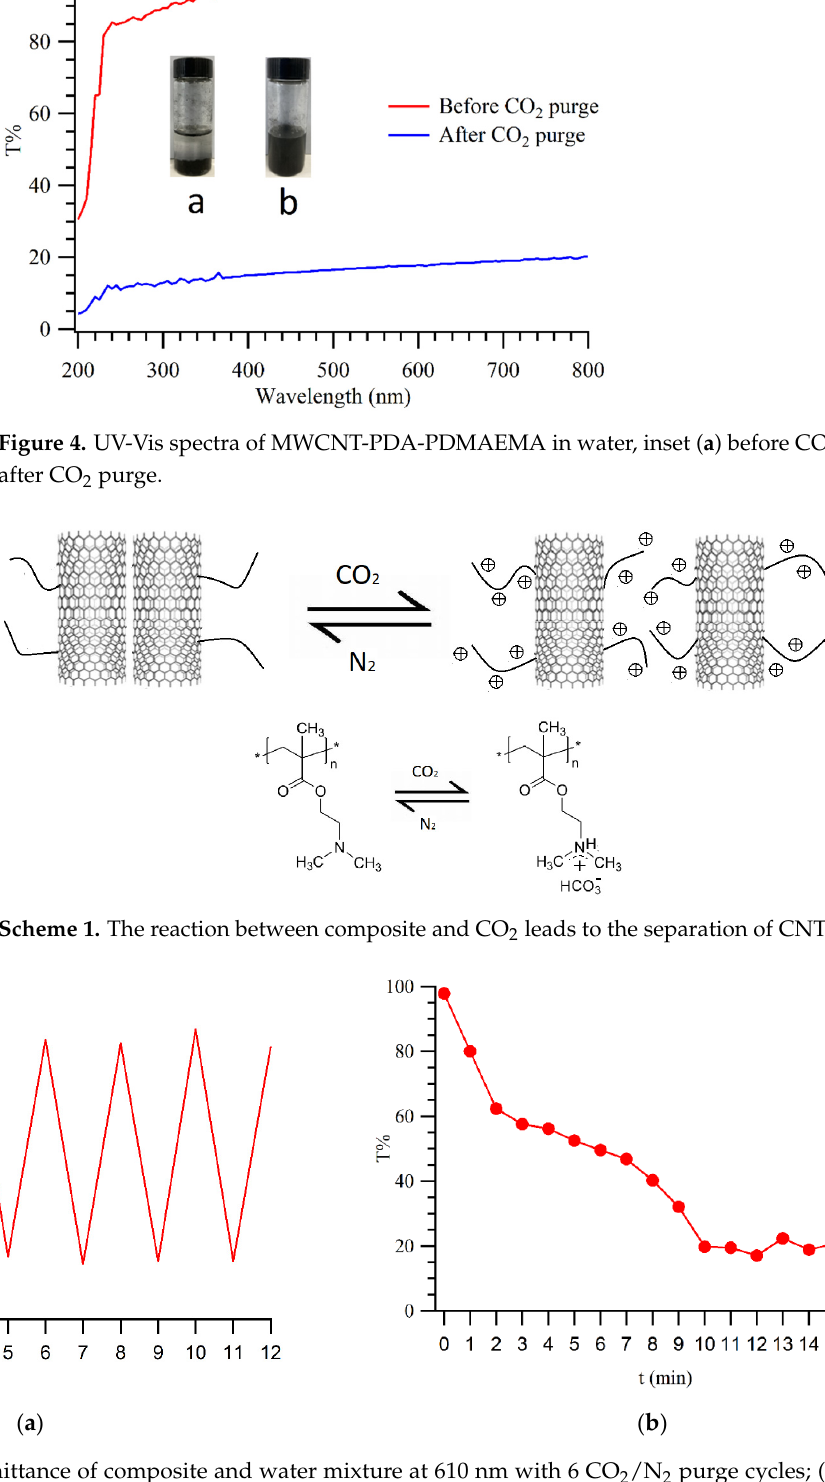
Figure 5. ( a ) UV-Vis transmittance of composite and water mixture at 610 nm with 6 CO 2 /N 2 purge cycles; ( b ) UV-Vis transmittance of composite and water mixture at 610 nm against time.